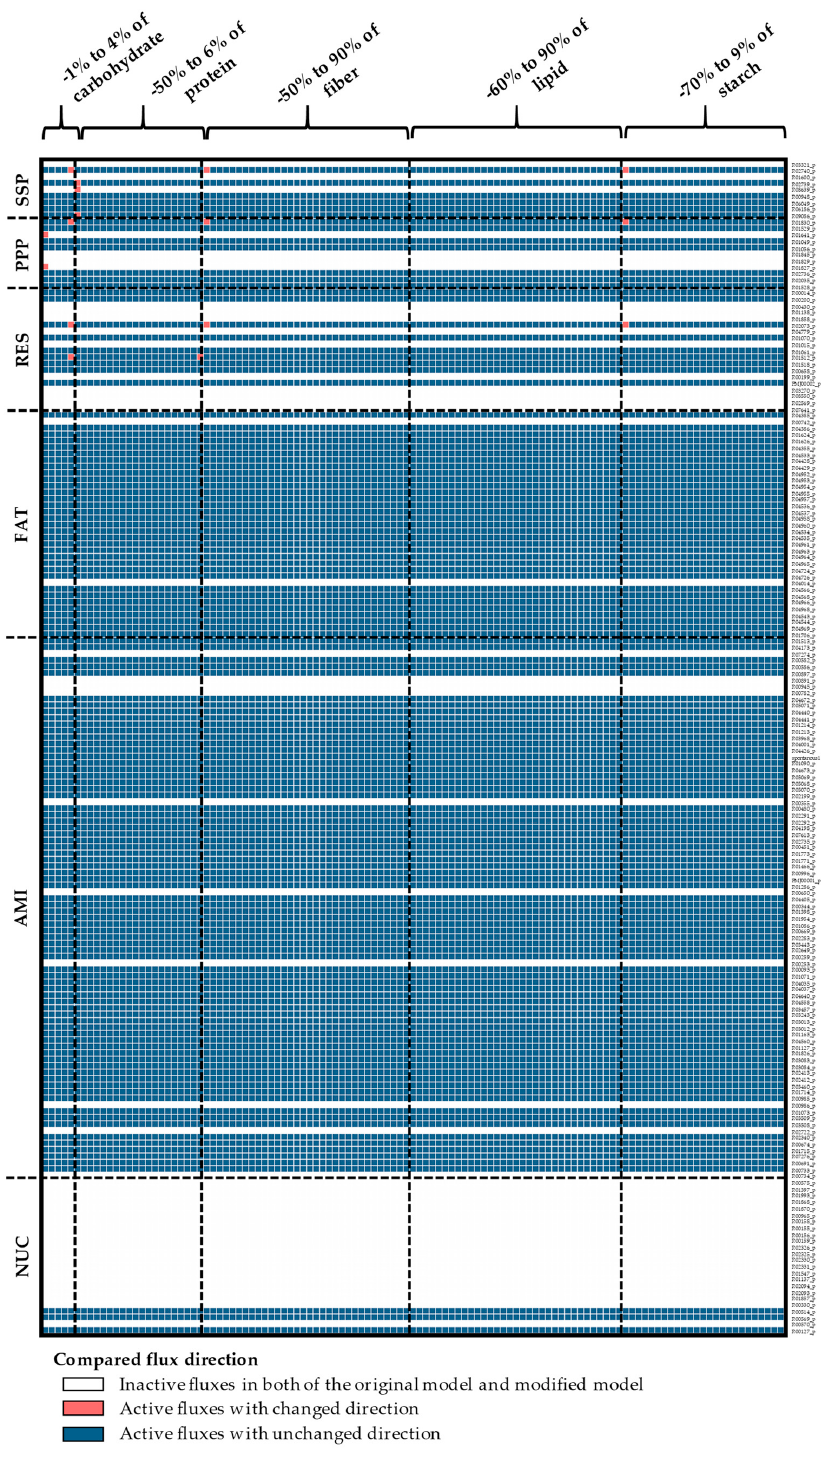
Figure A11. The sensitivity of plastidial reaction flux direction to variations in biomass content. Inactive reactions containing zero fluxes are denoted by white-colored grids. Active reactions, non-zero fluxes, with similar flux direction as the original model are denoted by blue grids; while those with dissimilar flux direction (breakpoint) are denoted by red grids. AMI, amino acid biosynthesis pathway; FAT, fatty acid biosynthesis pathway; NUC, nucleotide biosynthesis pathway; PPP, pentose phosphate pathway; RES, respiration pathway; SSP, starch and sucrose biosynthesis